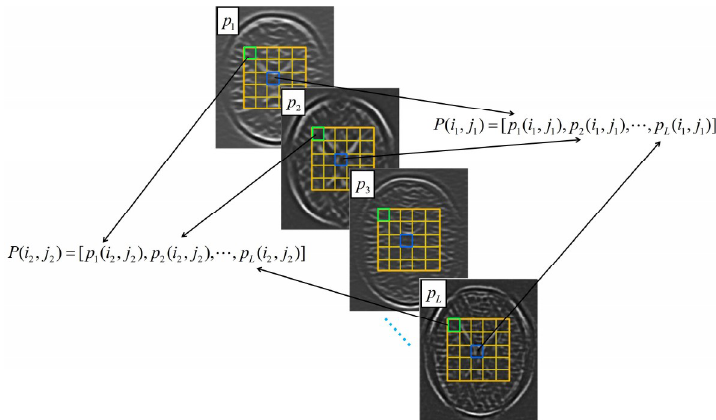
Figure 2. The construction of feature vectors based on the feature images of input MR images.